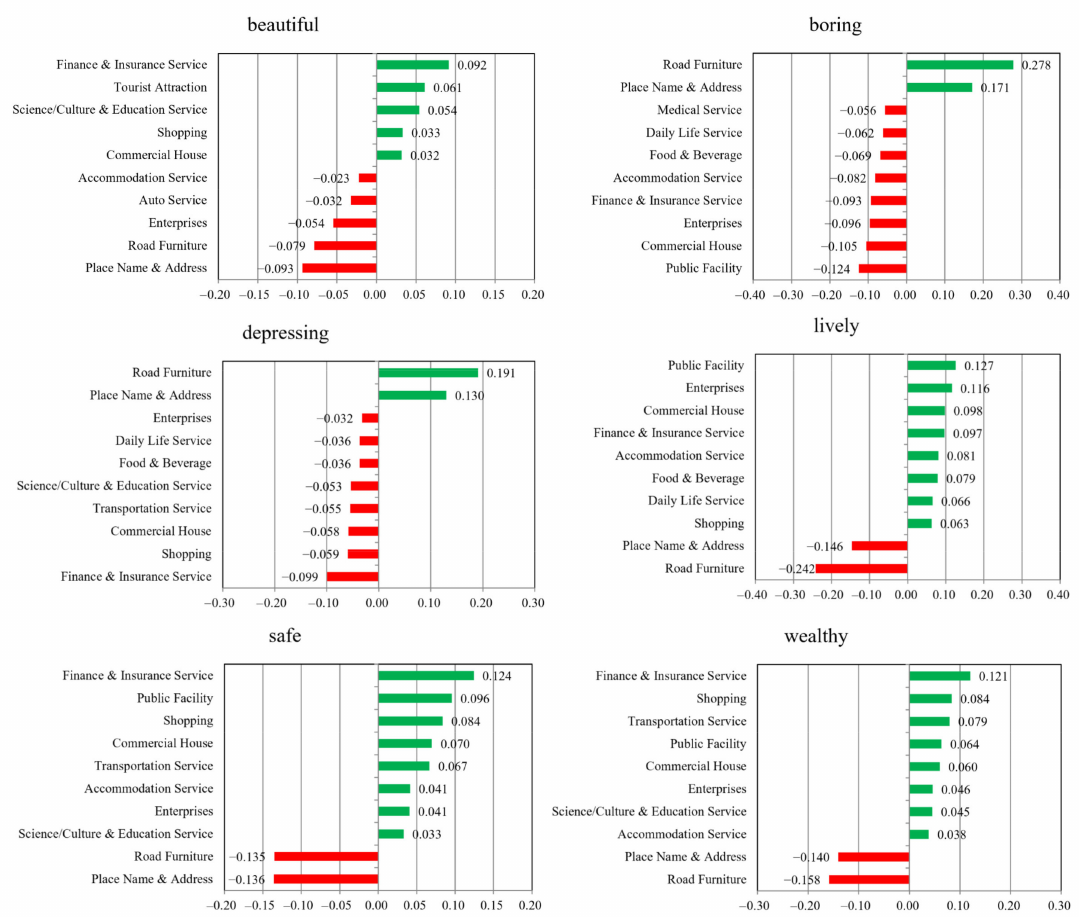
Figure 13. Results of the multiple linear regression analysis between the POI and the perception